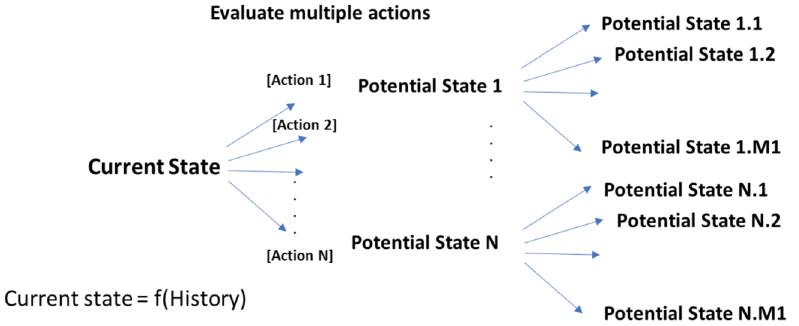
Figure 7. Simulating multiple action sequences.